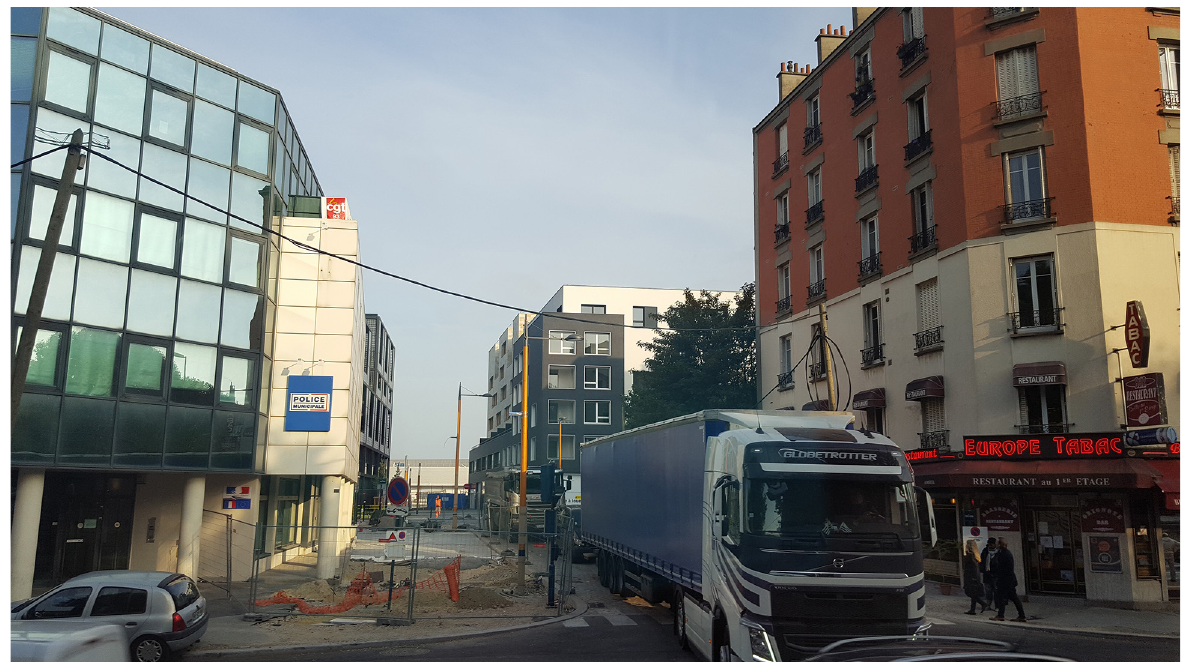
Fig. 5. Existing residential accommodation in Bobigny-Romainville with new apartment blocks in the background. Photo by Florian Weber